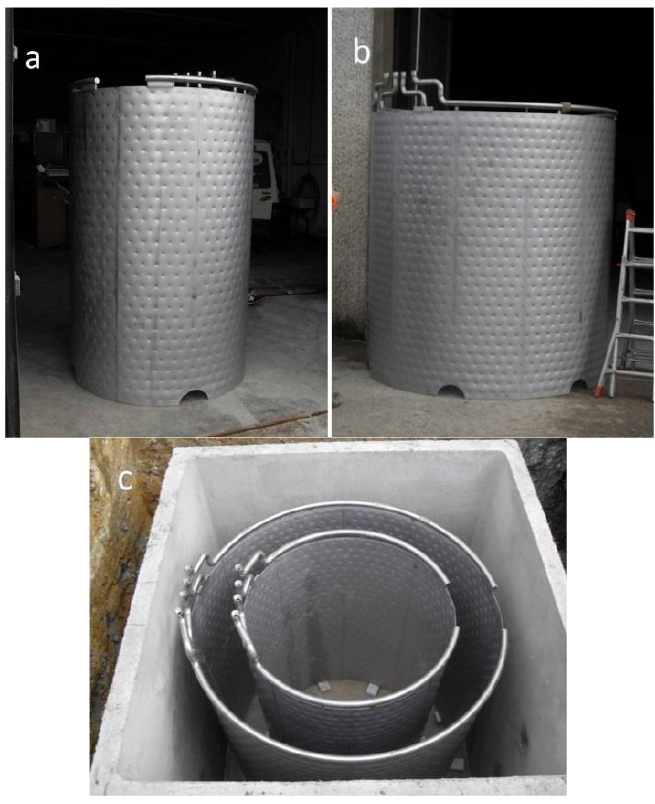
Figure 3. The cylindrical heat exchangers: ( a ) inside exchangers; ( b ) outside exchangers; ( c ) view of the heat exchanger assembly within the thermal storage.